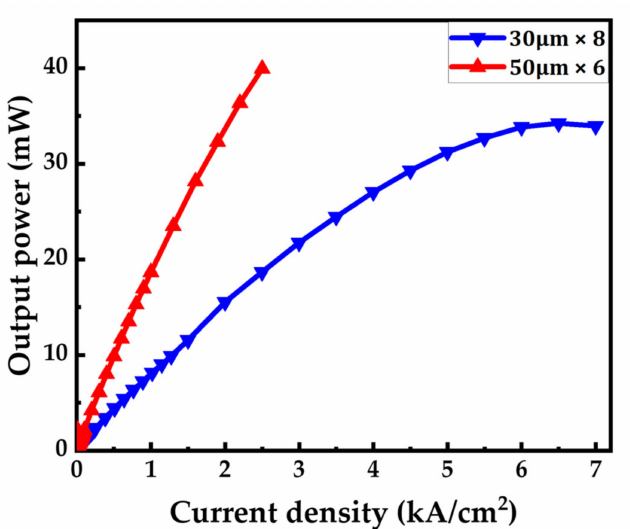
Figure 4. The current density versus optical power of 30 µ m × 8 and 50 µ m × 6 micro-LED